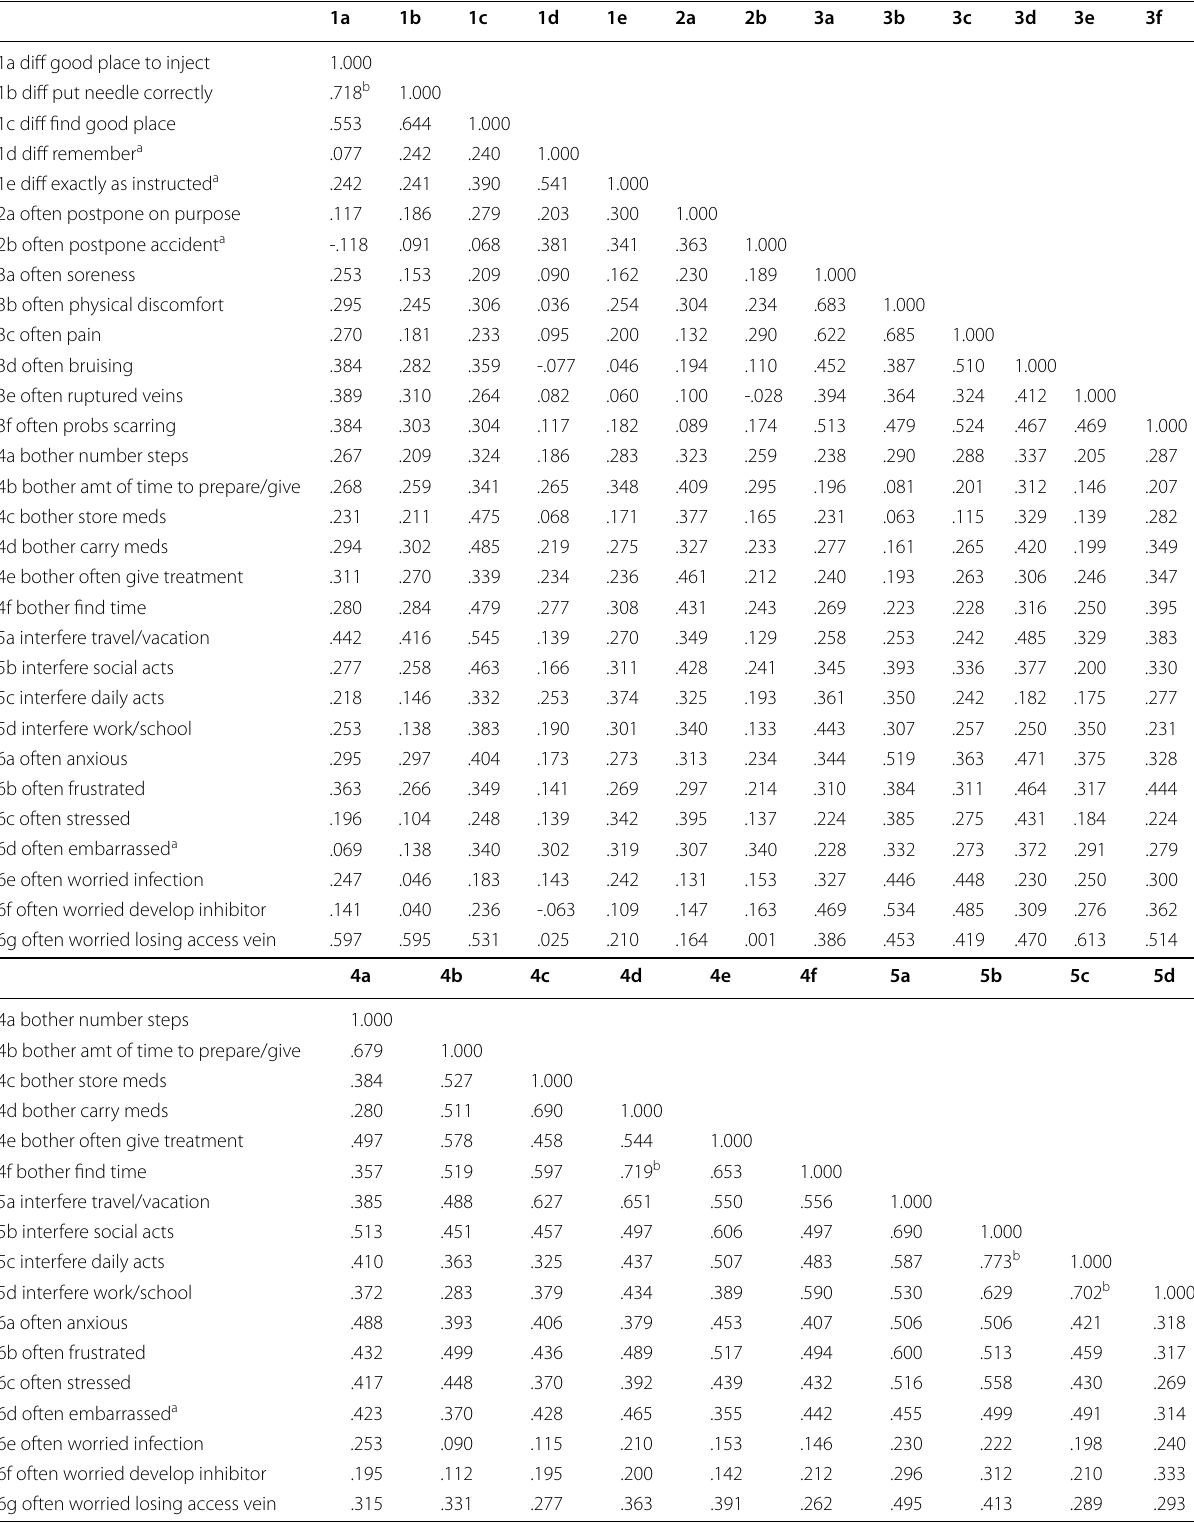
Table 5 Hemo-TEM item correlations (total population, n